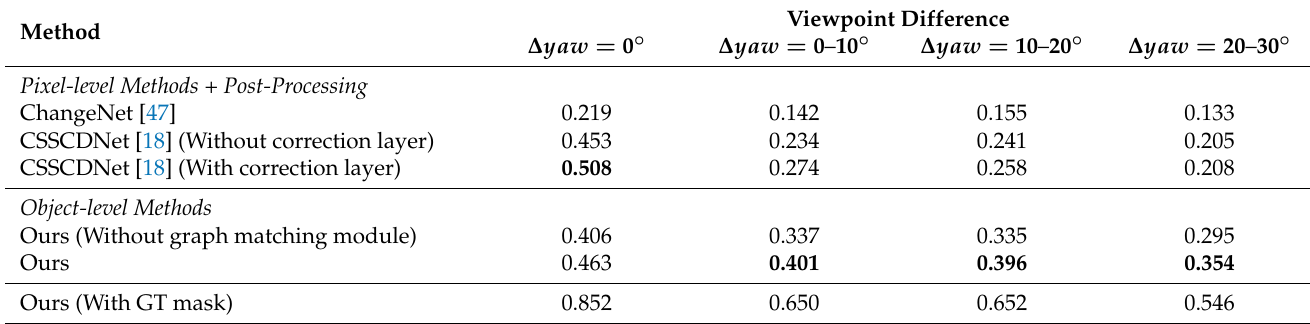
Table 2. Our evaluation of object-level change detection methods using the SOCD dataset. Our proposed network outperformed all baseline methods in terms of F 1 score when viewpoint differ- ences